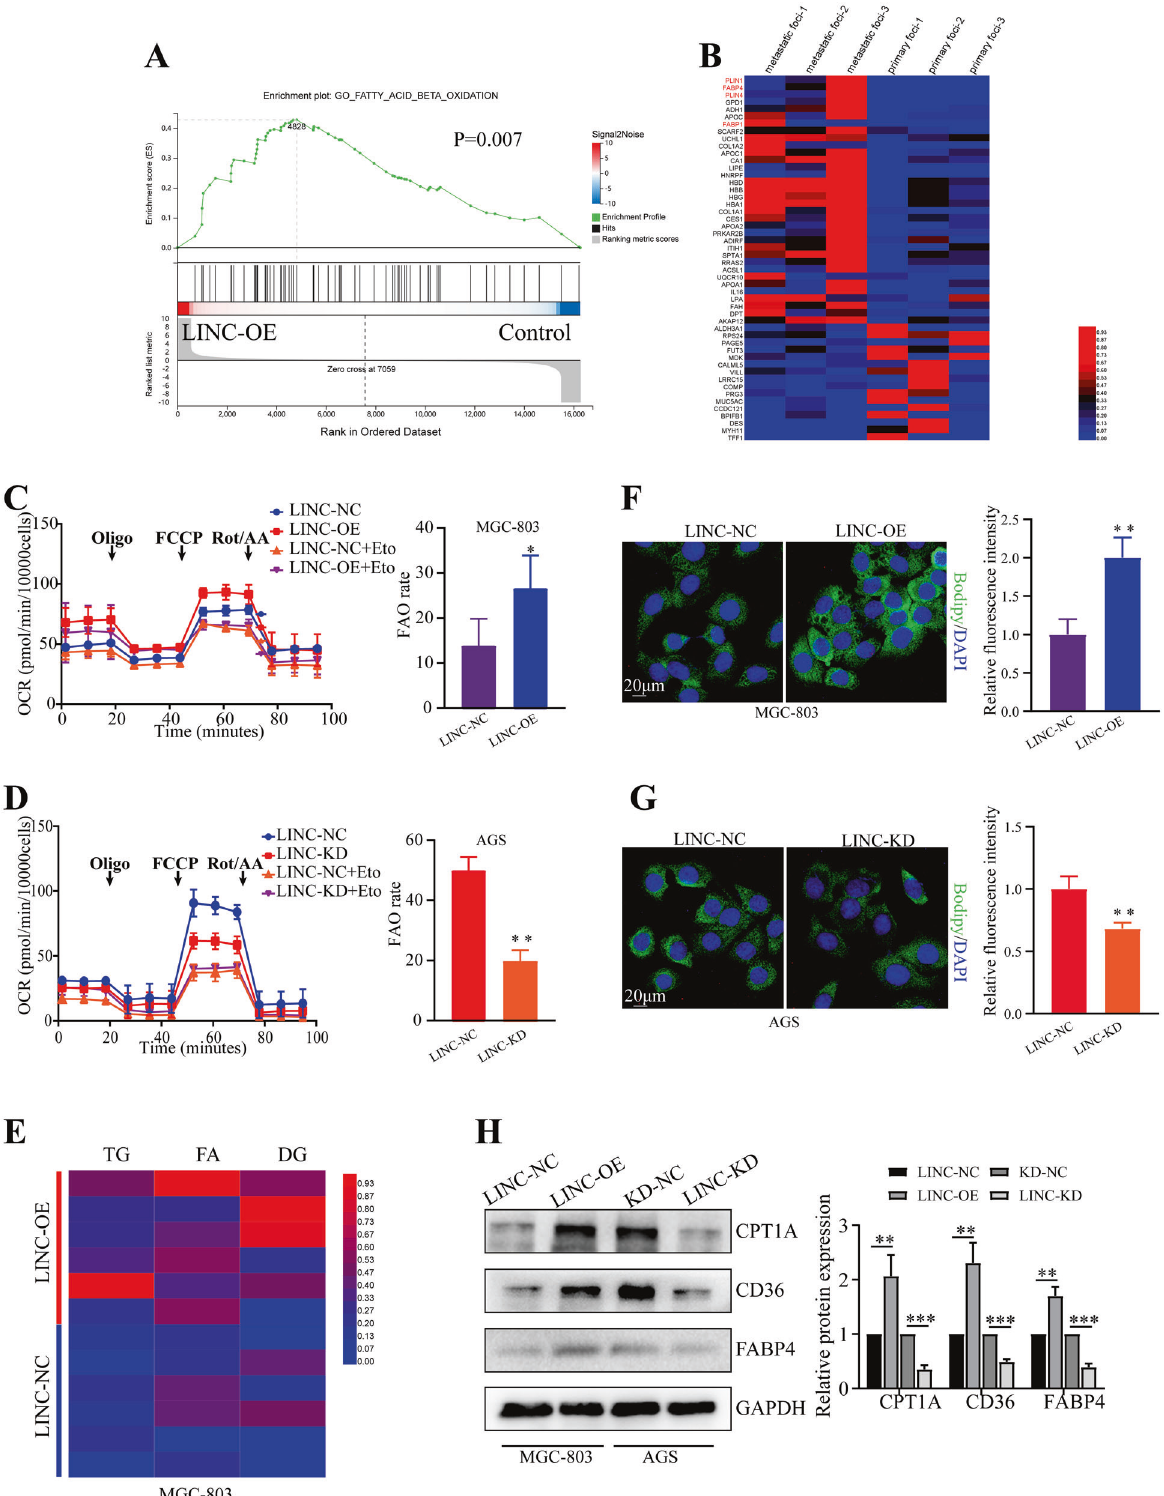
Fig. 2 LINC00924 expression promotes FAO and FA uptake. A GSEA of the RNA-sequencing (RNA-seq) data from LINC00924-OE and MGC803-NC cells. B Differential expression of proteins in 3 pairs of GC primary lesions and peritoneal metastatic lesions determined by protein pro fi le analysis. C , D Oxygen consumption rate (OCR) analysis in MGC803-NC/LINC-OE and AGS-NC/LINC-KD cell lines using palmitate as a metabolic substrate. MGC803 and AGS cells were treated with the CPT1 inhibitor ( + ETO) or vehicle ( − ETO). E Heatmap presenting differences in TG, FA, and DG from lipidomics between MGC803-NC and LINC-OE cell lines. F Lipid droplet staining in AGS-NC and LINC-OE cells. G Lipid droplet staining in MGC803-NC and LINC-KD cells. H WB analysis of CPT1A, CD36, and FABP4 in MGC803-NC and LINC-OE cells lines and in AGS-NC and LINC-KD cell lines. The protein levels were quanti fi ed with ImageJ.